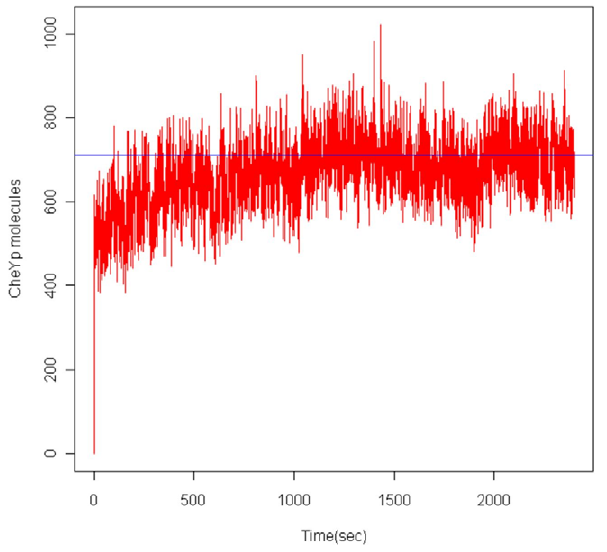
Figure 2. The variation in number of CheY-P molecules for the freely diffusing CheZ model.